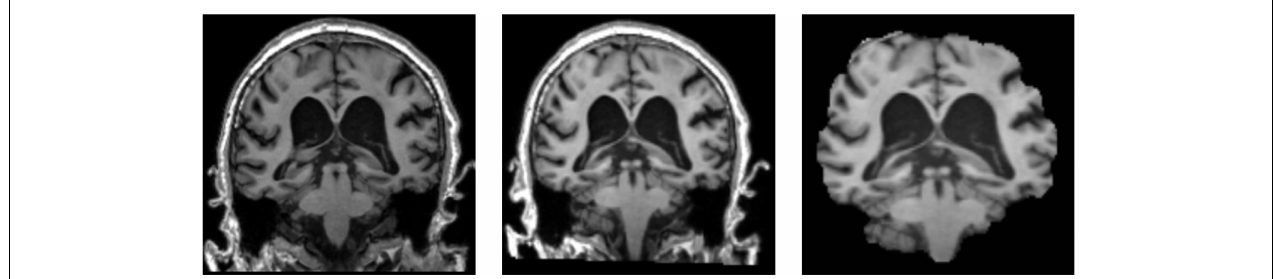
FIGURE 9 | Sample slices of MRI images after registration and skull